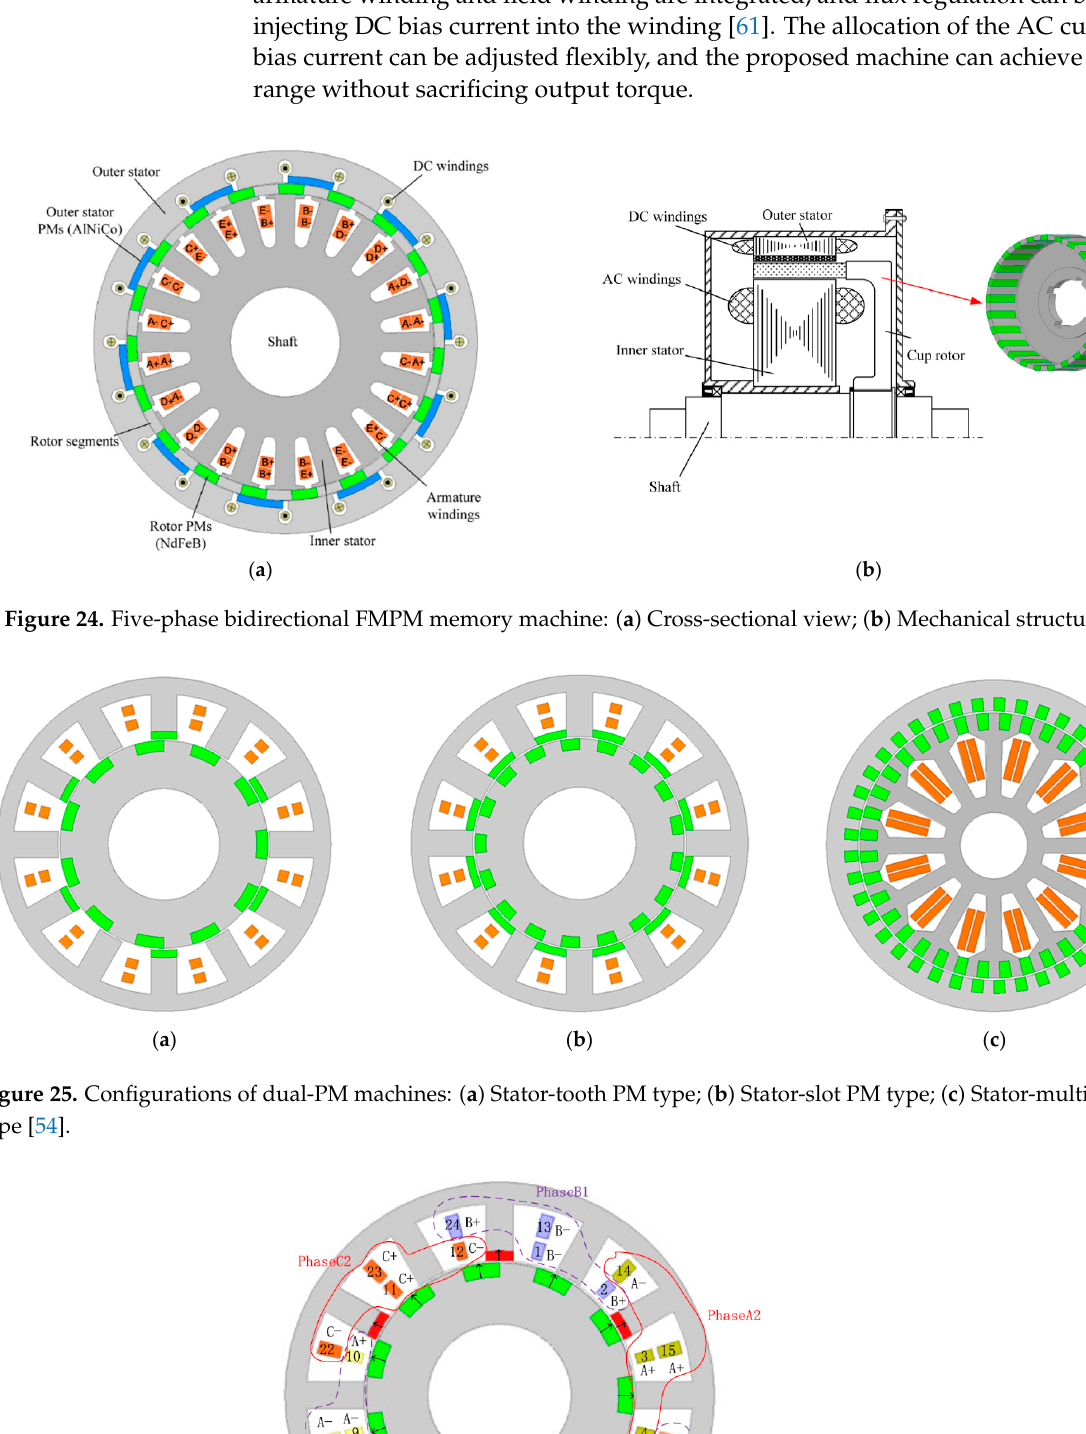
Figure 24. Five-phase bidirectional FMPM memory machine: ( a ) Cross-sectional view; ( b ) Mechanical structure [59].